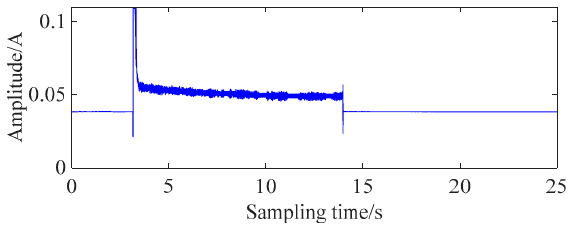
Figure 8. Signal of trash-in-gear fault.